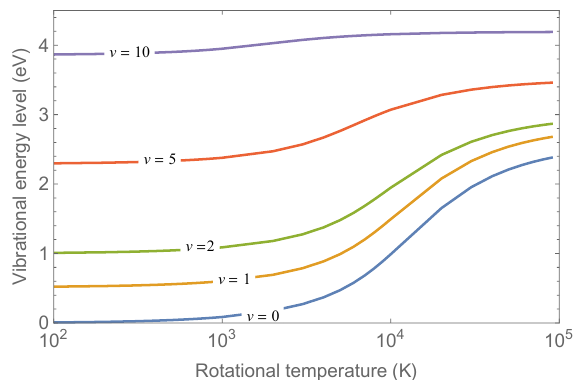
Figure 2. Rotationally-averaged vibrational energy levels (Equation (5)) as a function of the rotational